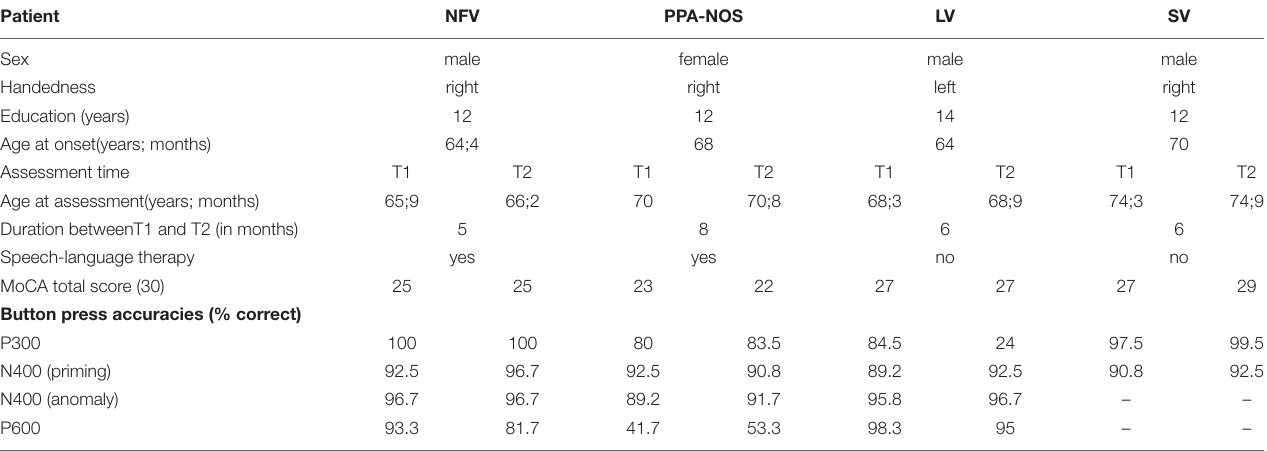
TABLE 2 | Demographic characteristics and button press accuracies of the included patients with PPA.